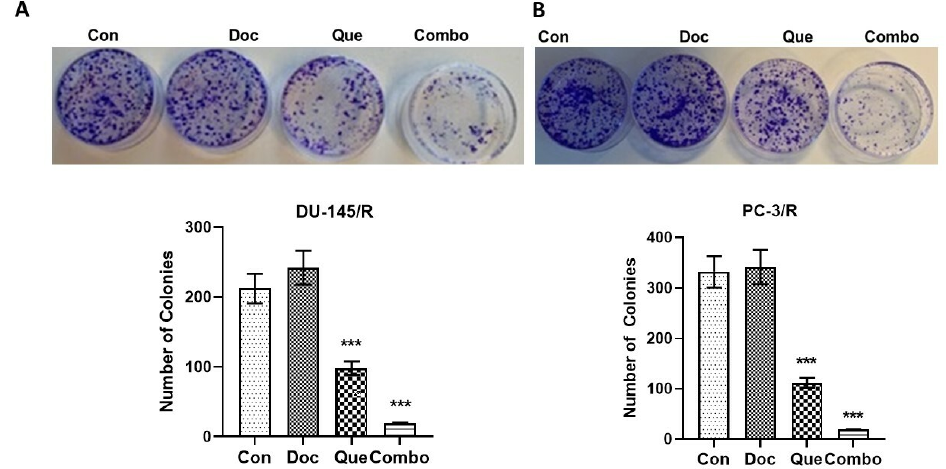
Figure 6. Effects of Doc and docetaxel + quercetin on colony-forming ability of resistant prostate cancer cell lines DU-145/R and PC-/R. The cells were treated as described in Section 2 with either the drugs individually or in combination and evaluated with respect to their effects on colony formation after 8 days. ( A ) DU-145/R cells and ( B ) PC-3/R cells. We performed the experiments in triplicate and the data are presented as means ± S.D. *** p < 0.001. The top panel shows representative images of the plate after 8 days. The bottom panel is the graphic representation of the mean and standard deviation of the number of colonies of three independent experiments performed in triplicate. The statistical significance of the difference between the control and treated cultures was calculated by Student’s t -test .